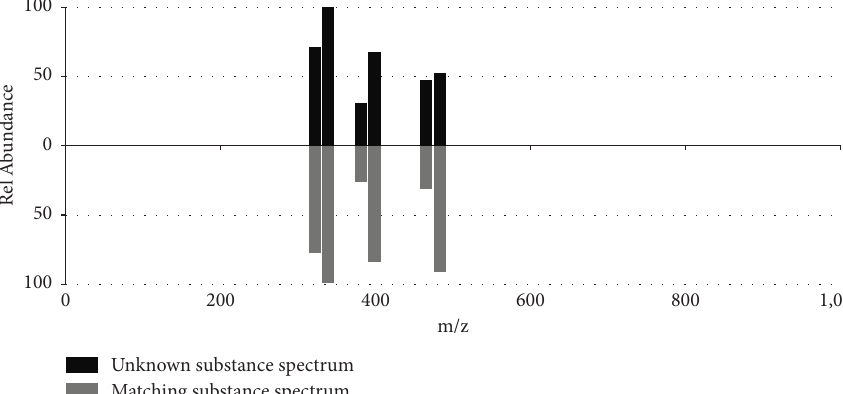
Figure 5: Detailed comparison page of the screening results (2D bar chart). In the 2D bar graph, the abscissa, ordinate, and upper half and lower halves of the graph, respectively, represent the m/z ratio, relative peak intensity, unknown substances, and matched